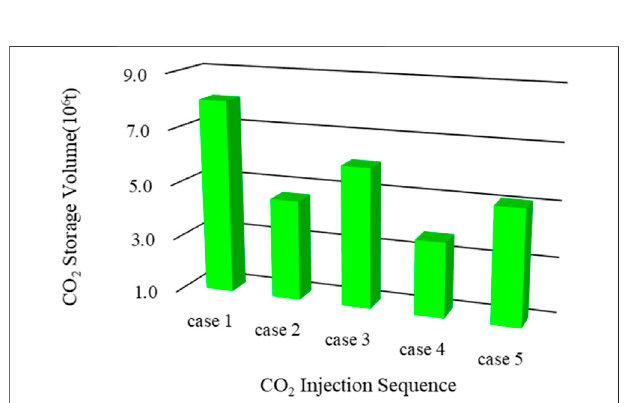
FIGURE 11 | CO 2 storage volume under different injection